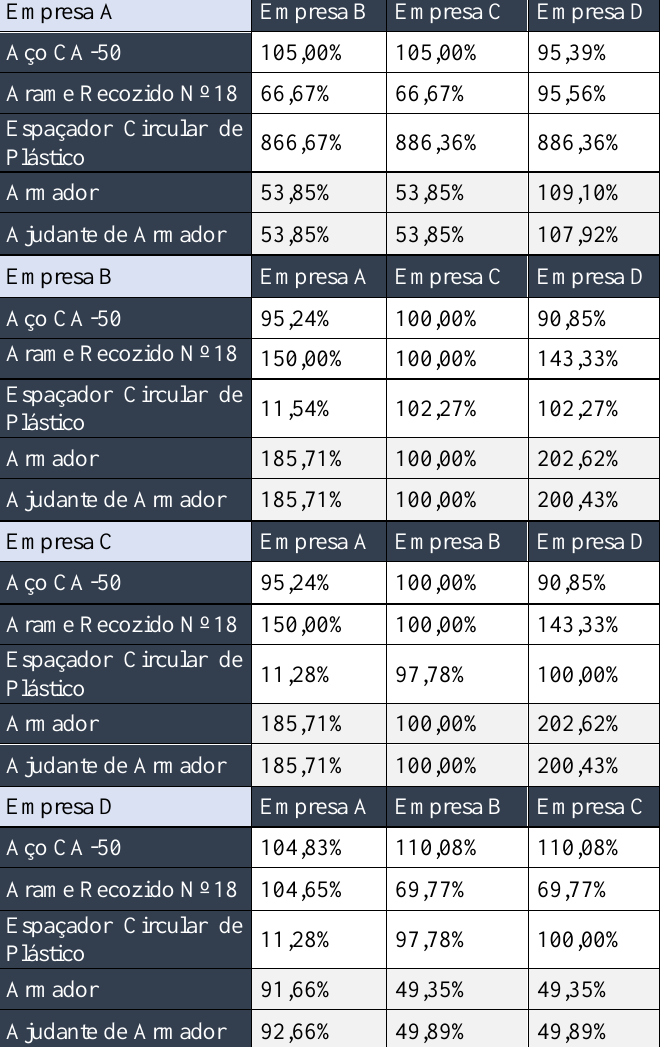
Tabela 5: Análise percentual dos índices de armação.